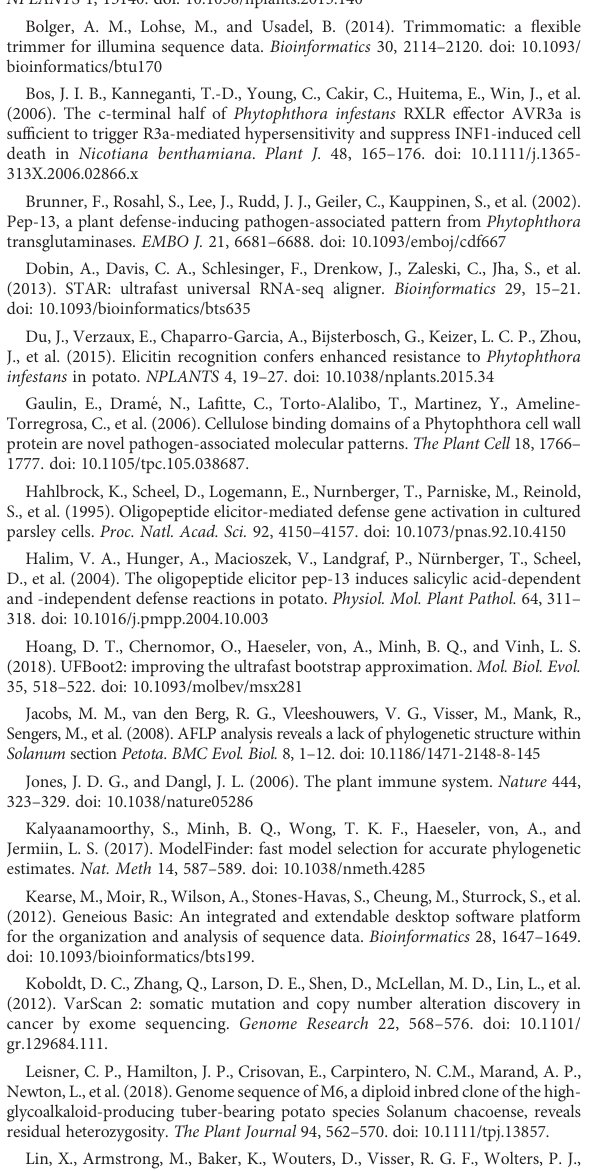
SUPPLEMENTARY FIGURE 3 Fine mapping of Pep-25 receptor The molecular markers were designed based on the potato reference genome (DM v4.03), the physical positions (Mb) of the markers on Chromosome 3 are shown in the fi rst line. The polymorphism of each SNPs is shown by “ NR ” (MCD360-1 allele) or “ R ” (3341-15 allele). The IDs of recombinants are shown on the left. Pep-25 responsiveness phenotype are noted by “ NR ” (non-responsiveness) or “ R ” (responsiveness). The haploid from responsive parent (3341-15) are highlighted by red, and the haploid from the non-responsive parent (MCD360-1) are highlighted by